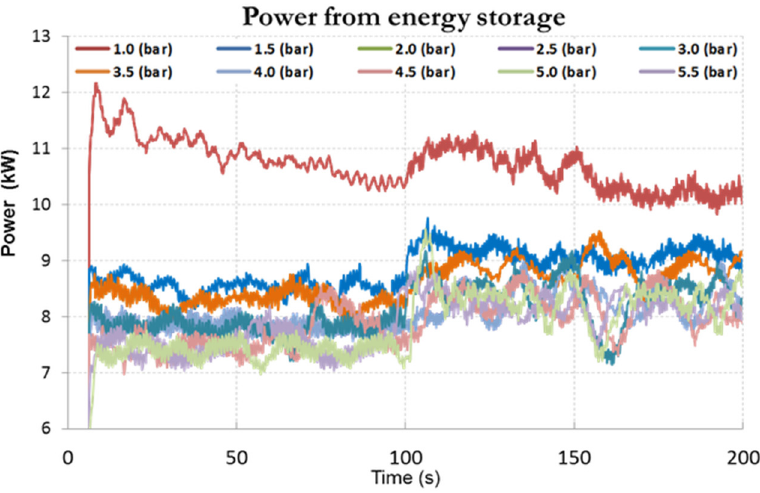
Figure 10. Influence of tire pressure changes on energy consumption from an accumulator package.